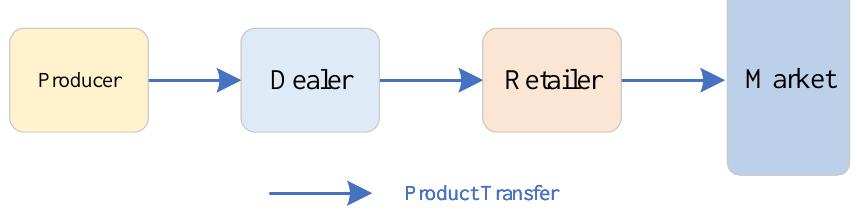
Figure 1. Schematic diagram of three-level single chain tandem supply chain